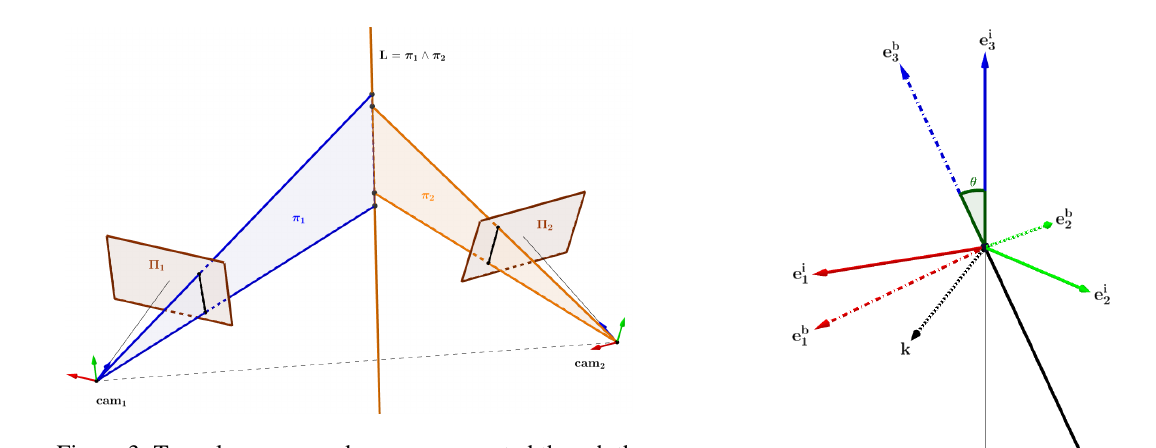
Figure 3: Two planes, π 1 and π 2 , are generated though the origin of each camera coordinate system and the detected line on each image plane, and the inter- section generates the line, L , representing the de- tected wire in 3D space.